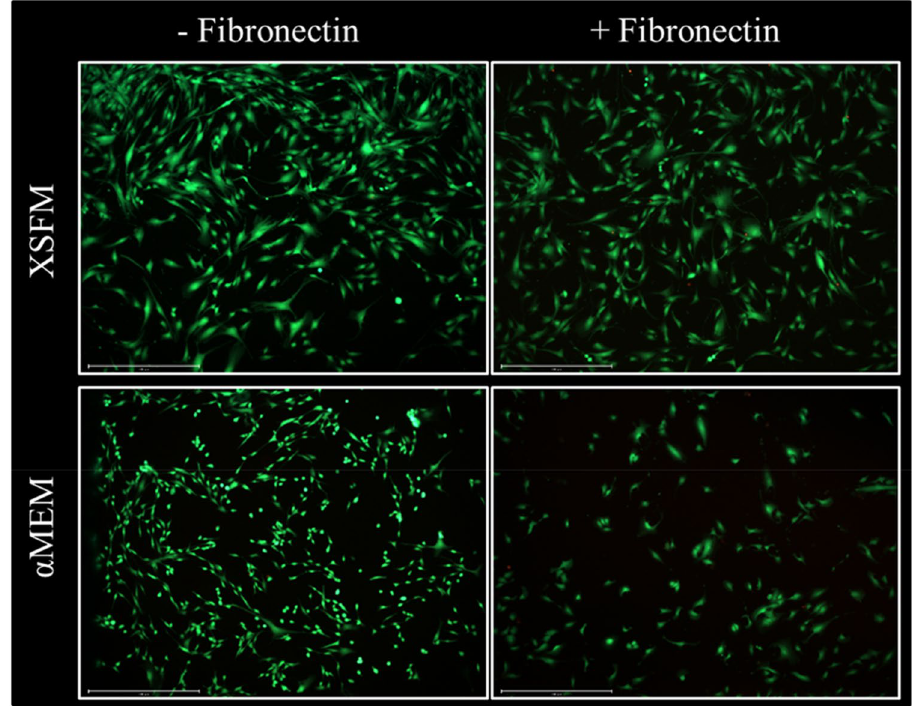
Figure 1. Live/Dead assay of BMSCs seeded on a glass chamber slide, with or without fibronectin coating, and cultured with αMEM/FBS/FGF2 or with a chemically defined medium (XSFM) for 72 h. Green: Calcein-AM that stains live cells; red: ethidium homodimer for dead cells. Scale bar (bottom left in each panel): 200 µm. Figure representative of n = 5 biological replicates.